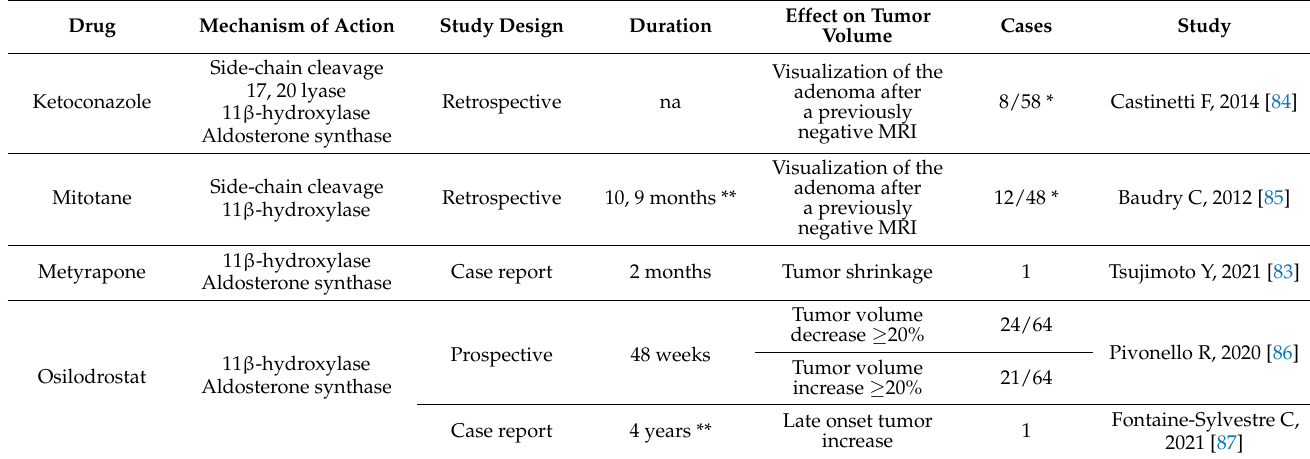
Table 2. Effects of steroidogenesis inhibitors on corticotropinomas’